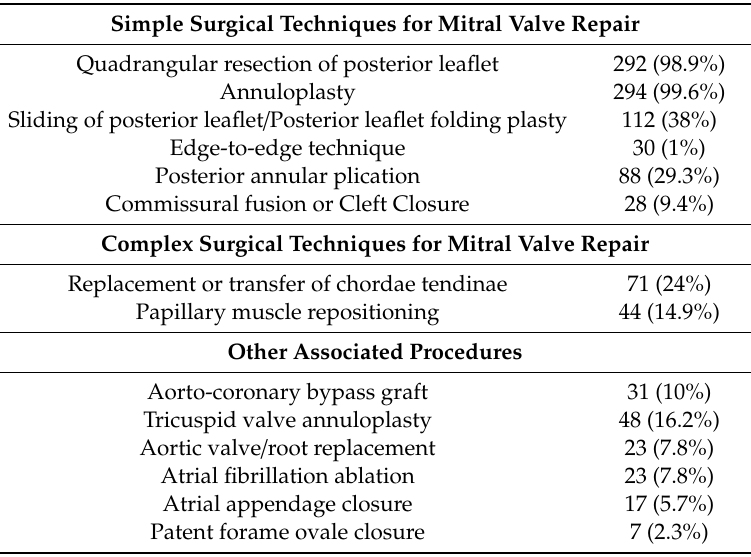
Table 2. Surgical techniques used in the study population.